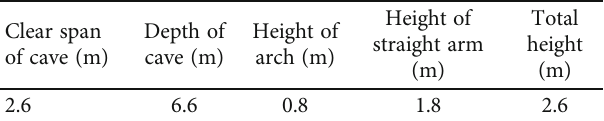
Figure 3: The geometrical parameters of single-hole cli ff -side loess cave Table 1: Geometrical dimensions of single-hole cave dwelling.